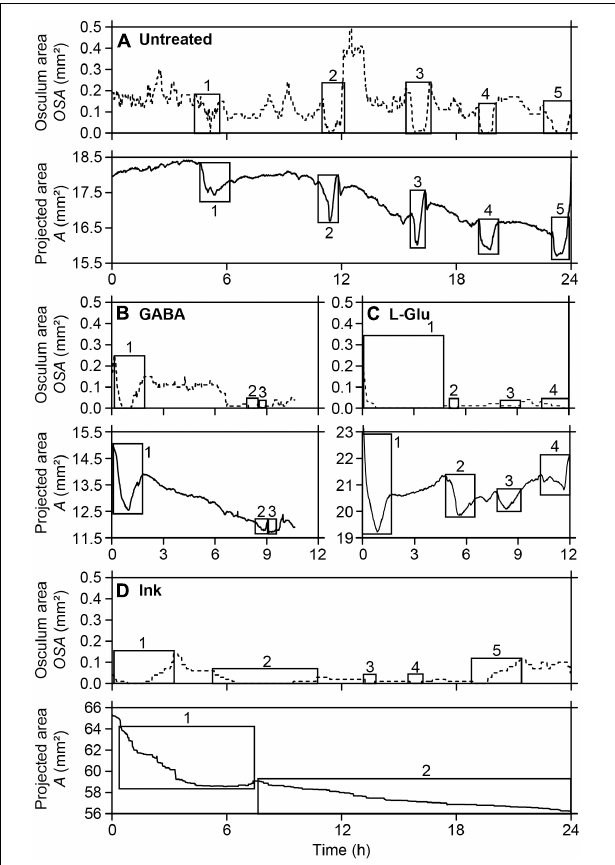
FIGURE 2 | Halichondria panicea . Repeated contraction-expansion events (squares) in single-osculum explants, expressed by changes in the osculum cross-sectional area (broken lines) and projected area (solid lines). (A) Untreated explant ( ID #1), (B,C) explants after exposure to the neurotransmitters γ -aminobutyric acid (GABA, 1 mM; ID #11) and L-glutamate (L-Glu, 1 mM; ID #13), (D) explant after exposure to inedible particles (ink, 4 mg L − 1 ; ID